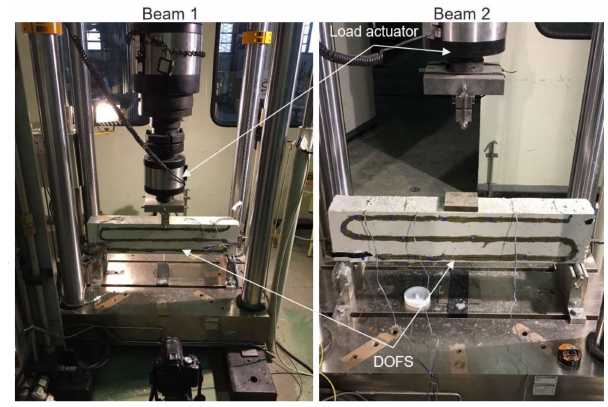
Figure 7. Reinforced concrete beam specimen 1 ( left ) and 2 ( right ).